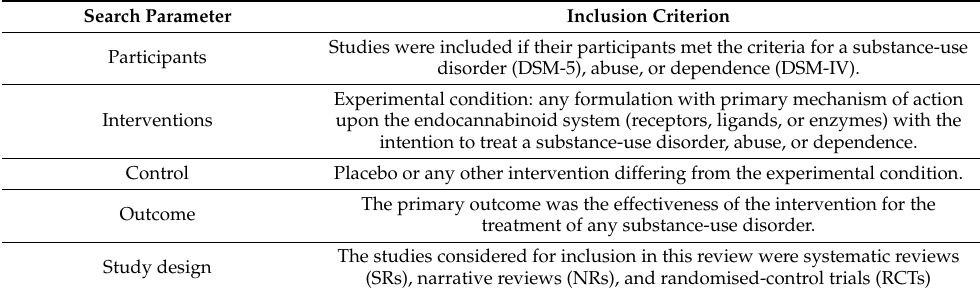
Table 1. PICOS Search algorithm–scoping review using a systematic